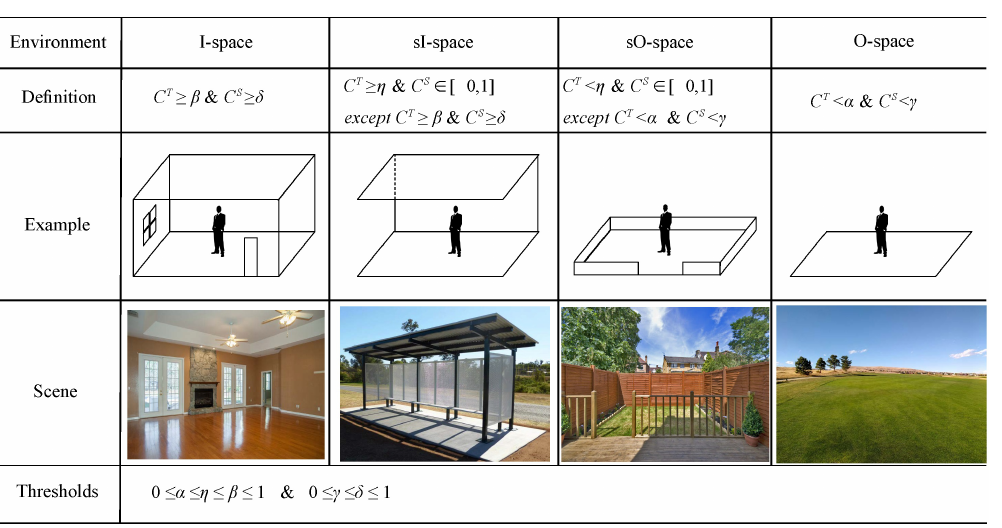
Figure 2. Quantified generic space definition framework based on top closure ( C T ) and side closure ( C S ) [21]. On the basis of their visual inspection, they set the following ratio values for the five thresholds: α = 0.05, β = 0.95, γ = 0.05, δ = 0.95 and η =